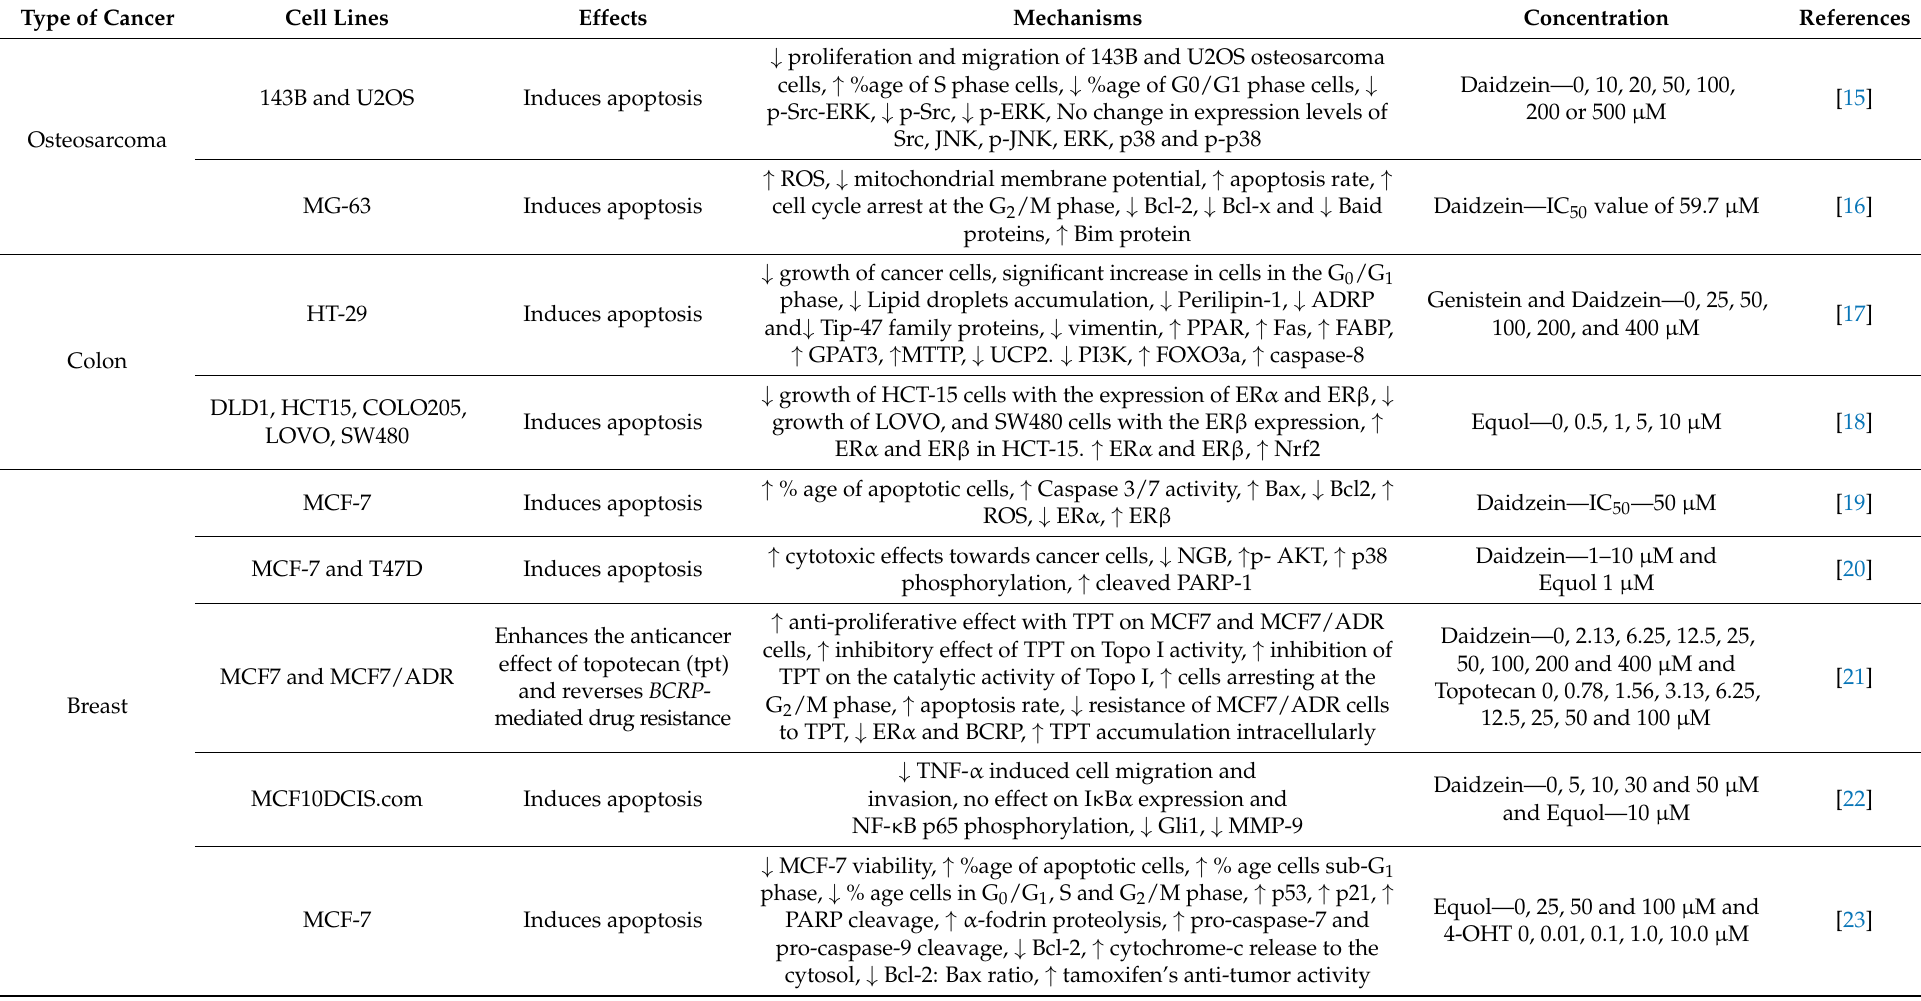
Table 1. Anticancer effects of daidzein and its metabolites including equol based on in vitro